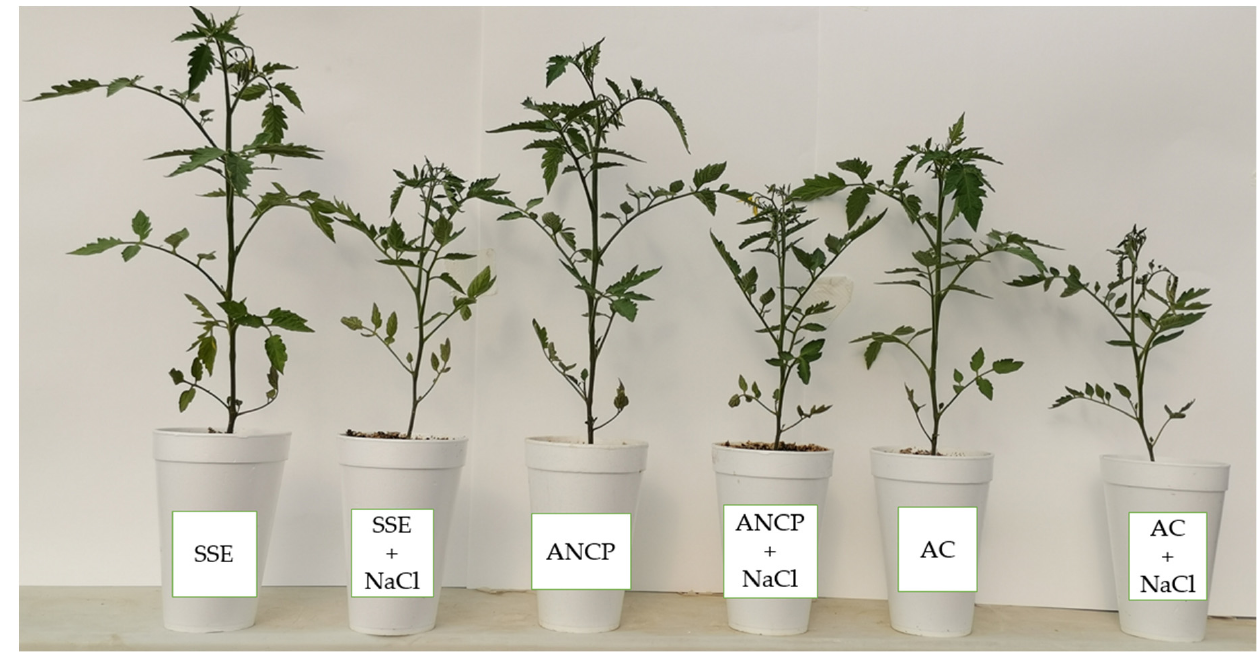
Figure 1. Tomato seedlings in the experimental assay. SSE: Sargassum spp. seaweed extracts; ANCP: A. nodosum commercial product; AC: Absolute control; NaCl: 100 mM sodium chloride.